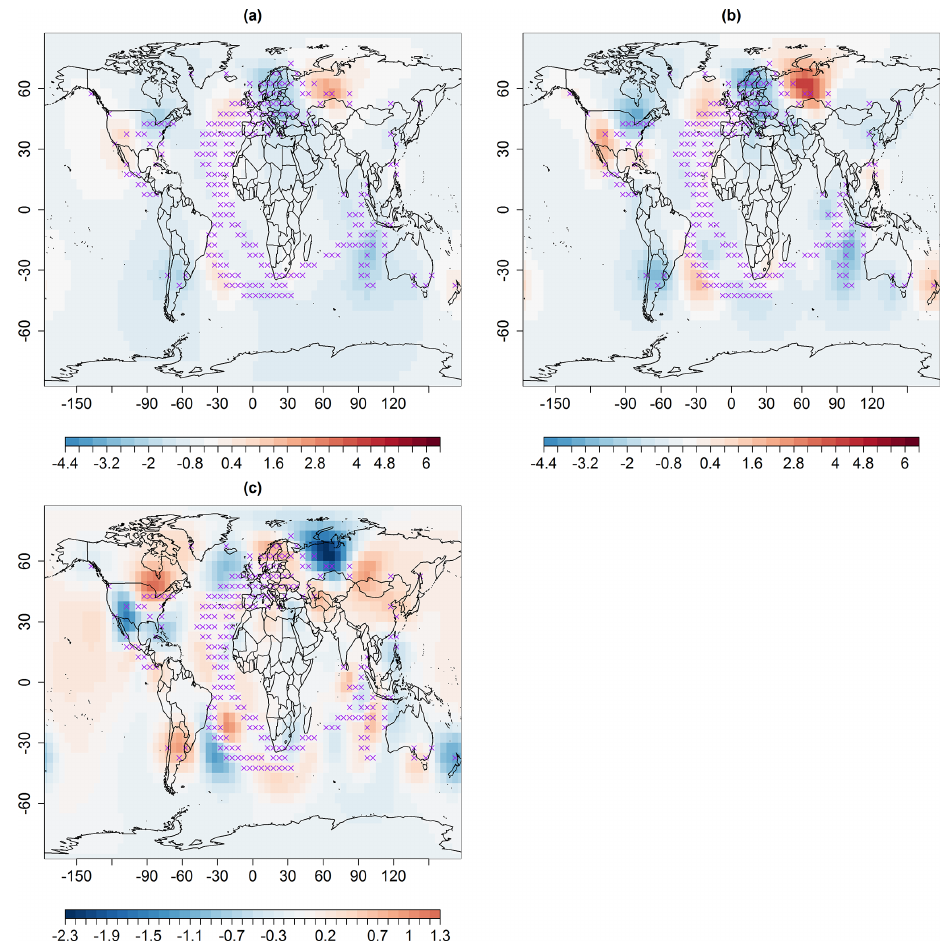
Figure 3. Median spatial predictions (in degrees Celsius) for May 1861 using multi-resolution lattice kriging based on (a) ABC, using a variogram (Sect. 2.1), and (b) the profile maximum likelihood approach (Nychka et al., 2015) used to create data in Ilyas et al. (2017). (c) The difference in panels (a) and (b) , i.e., panels (a) – (b) . The × signs show observed spatial sites